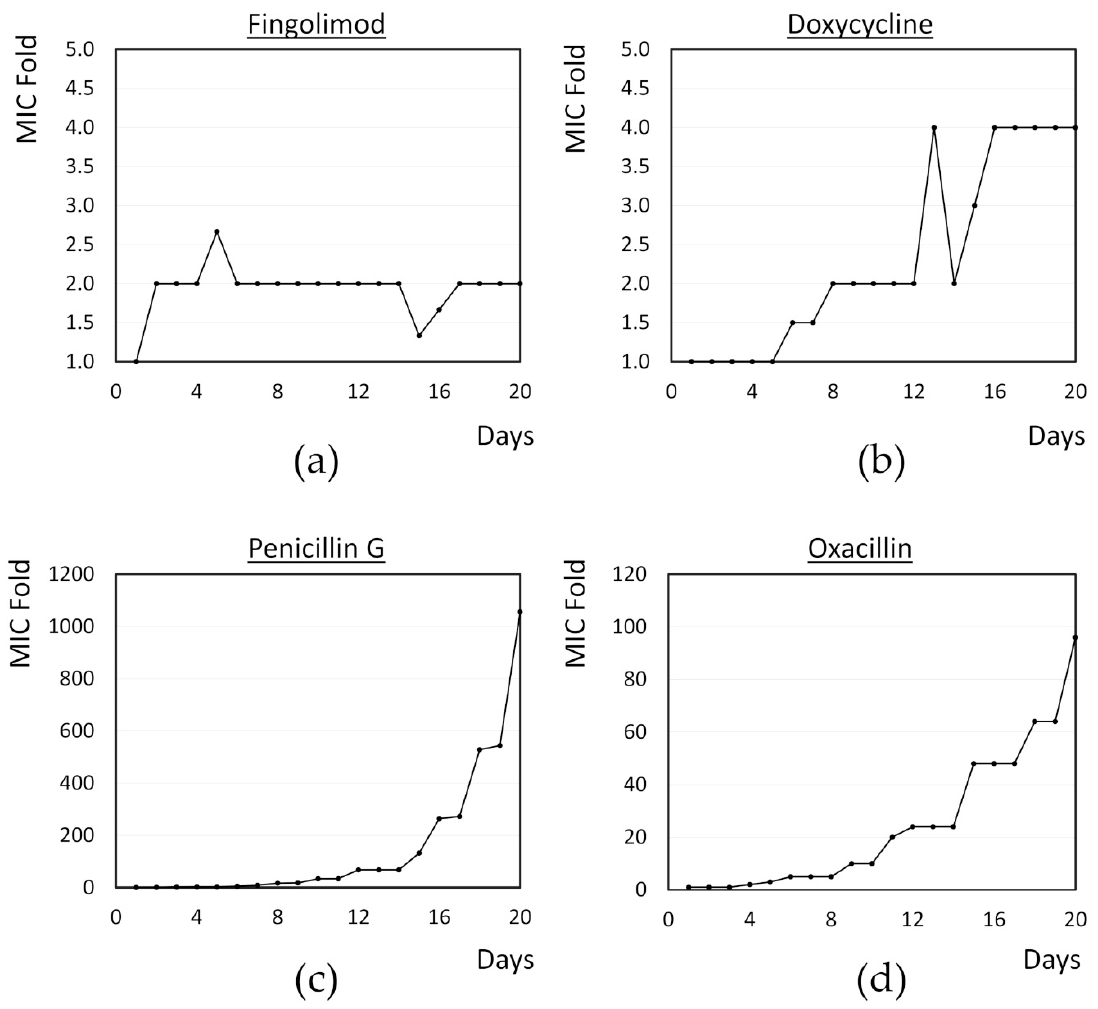
Figure 6. MIC doubling over time for S. aureus exposed to sub-inhibitory concentrations of ( a ) fingolimod; ( b ) doxycycline; ( c ) penicillin G; and ( d ) oxacillin for 20 days. Results are the average obtained for two to three biological replicates.